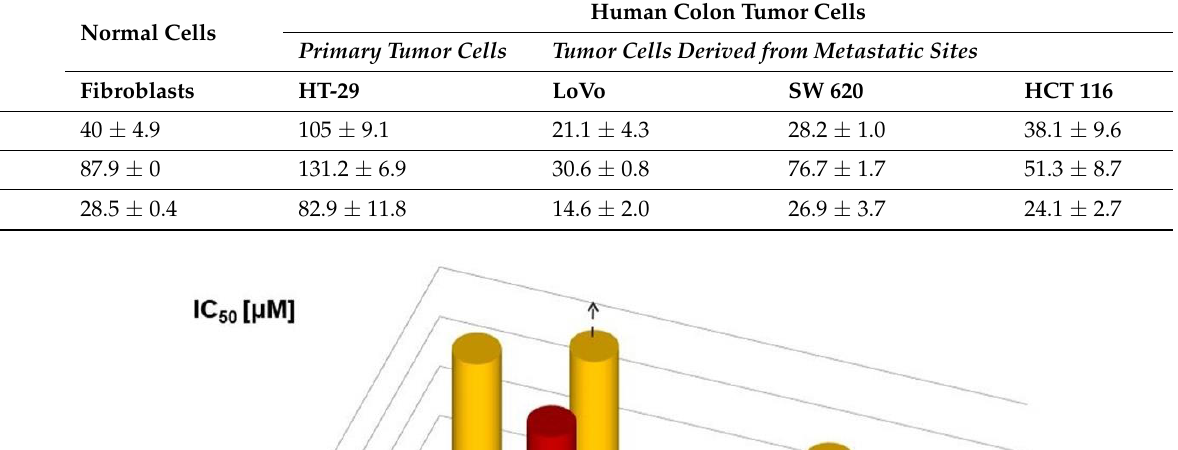
Table 4. Cytotoxic effects (IC 50 , µ M/L) as mean values with estimated SD of Na-isoO, Na-35dcpa , Na-nicO against normal human fibroblasts (BJ) and human tumor cells (HT-29, LoVo, SW 620, HCT 116). Experiments were repeated three times with similar results.